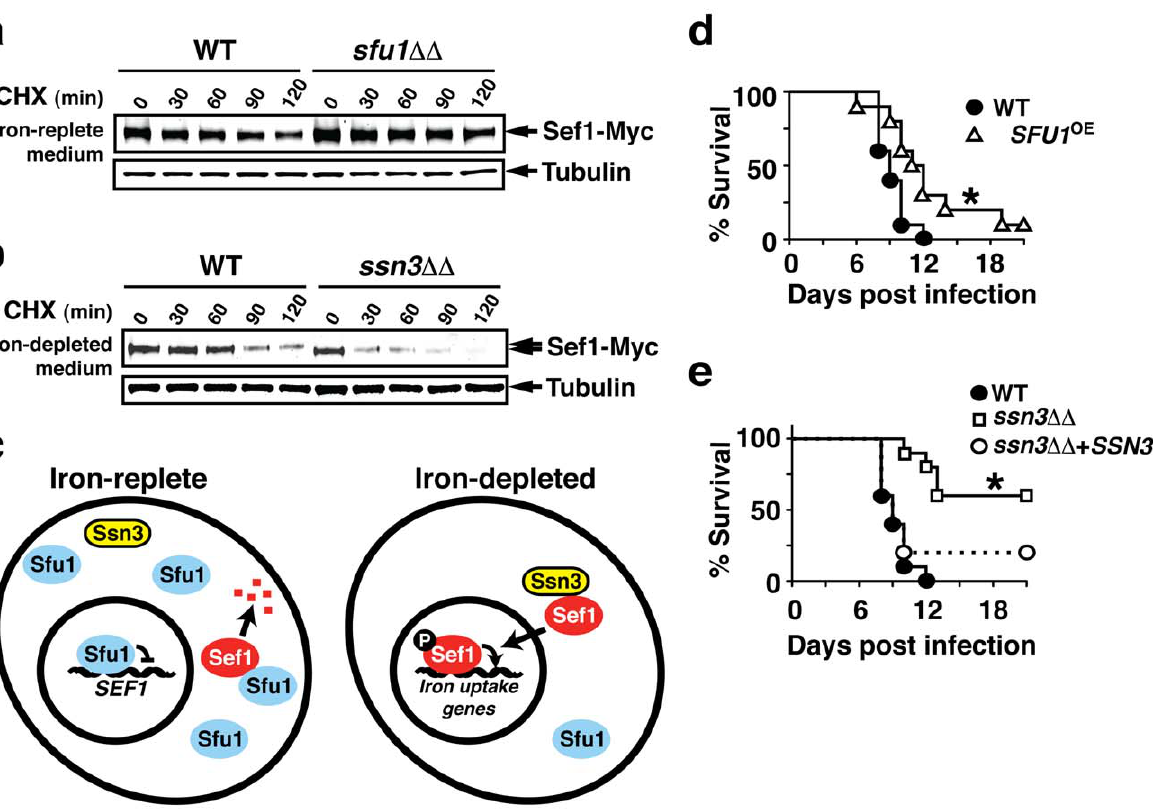
Figure 4. Sfu1 and Ssn3 mediate opposing effects on Sef1 stability and virulence. a) Sef1 protein is stabilized in an sfu1 DD mutant. Wild- type or sfu1 DD strains containing Sef1-Myc were propagated in iron-replete medium containing 2 mg/ml cycloheximide. Samples were recovered at the indicated time points, and Sef1-Myc was visualized using monoclonal antibodies against the Myc epitope, followed by incubation with secondary antibodies that were coupled to infrared dyes and quantified using a Li-Cor instrument. Note that a single band corresponding to higher mobility (unphosphorylated) Sef1 is present in both strains. b) Sef1 protein is destabilized in the ssn3 DD mutant. The experiment was performed as above, except that cells were propagated in iron-depleted medium containing cycloheximide. Note that phosphorylated Sef1 recovered from wild-type cells runs with slower mobility. c) Model for Sef1 regulation by Sfu1 and Ssn3 under iron-replete vs. iron-depleted conditions. Note that, even under iron- replete conditions when nuclear Sfu1 functions as a transcriptional repressor, a cytoplasmic pool of Sfu1 is available ( Figure S4 ) that could participate in Sef1 sequestration. d) Overexpression of SFU1 leads to attenuated C. albicans virulence in a murine bloodstream infections model. * signifies p , 0.02, log-rank test. E) Deletion of SSN3 leads to attenuated C. albicans virulence, and restoration of one copy of wild-type SSN3 complements the defect. * signifies p , 0.0001.